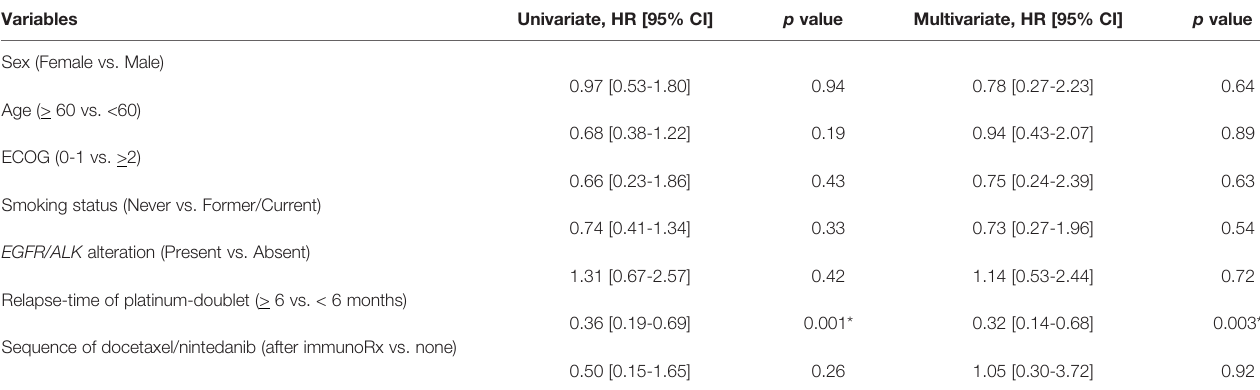
*Statistically signi fi